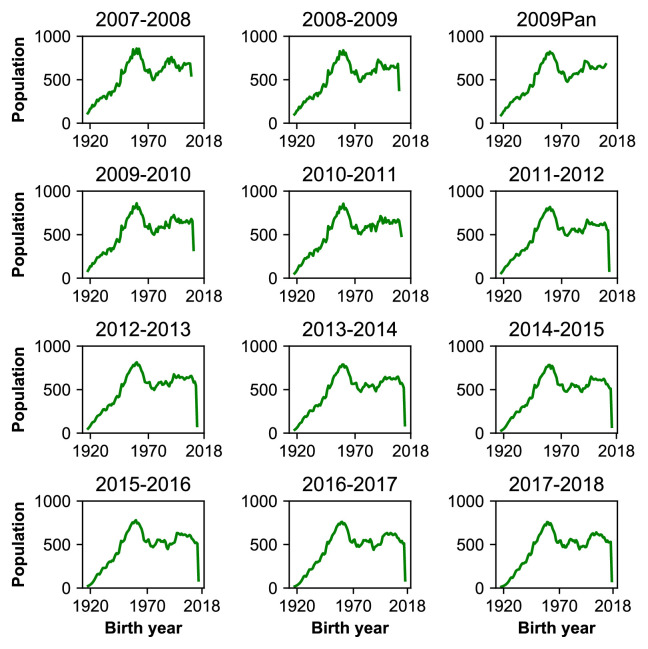
Birth year distribution of population.Each panel shows the population distribution of all individuals in the study area who met the age criteria for study enrollment. People under 6 months old at the start of the sampling period in a season were not eligible to participate.